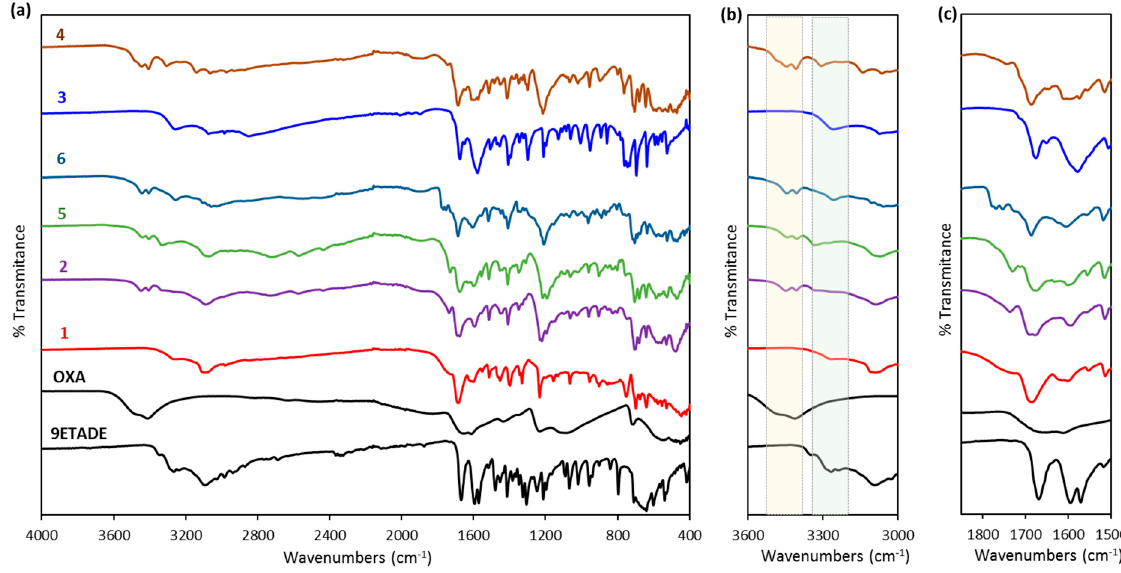
Figure 2. FT-IR spectra of ( a ) 9ETADE, oxalic acid dihydrate and the as-synthesized compounds in the full range, and in the ranges ( b ) 3600–3000 cm -1 or ( c ) 1850–1500 cm − 1 .